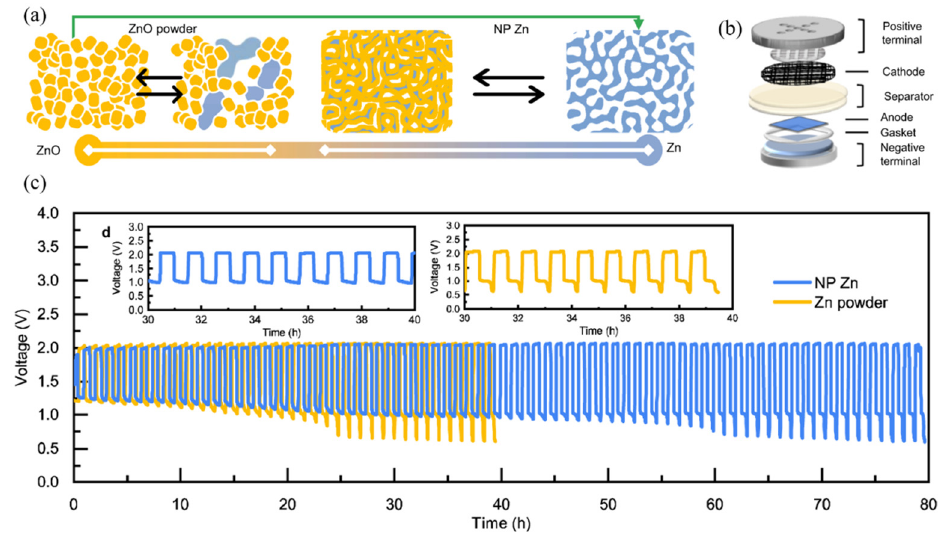
Figure 6. ( a ) Representation of the distinct pathways of transformation with unmixed ZnO (shown by yellow color) on the extreme left and unmixed zinc (shown by blue color) on the extreme right. The ZnO powder is the anode, and the transition is between powder and clusters of zinc metal (in the left-black arrows). Alternately, enhanced transition (shown by the green arrow) results in nanoporous zinc (in the right-black arrows), ( b ) schematic presentation of the zinc–air coin cell reported. and ( c ) potential vs. time curves at current density of 10 mA/cm 2 with 10% DoD. [30]. Reprinted with permission from Ref. [30], Copyright 2022, Springer Nature.